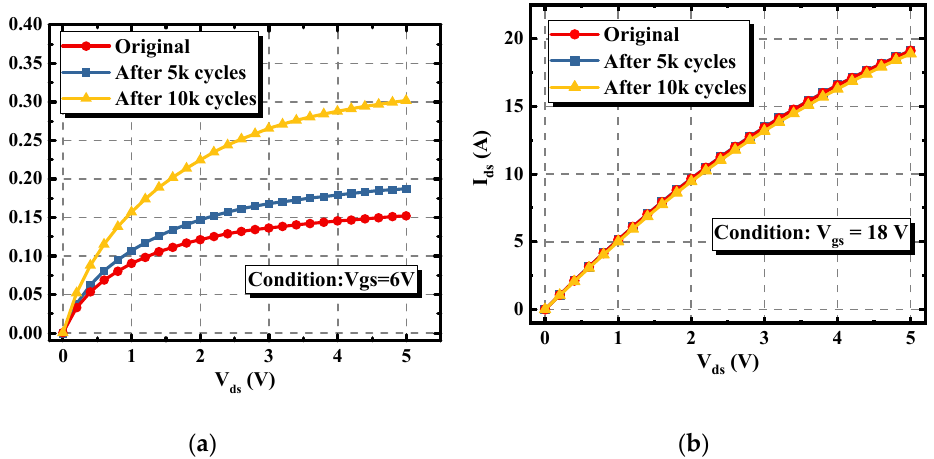
Figure 5. Variations of the I d -V d characteristic of the asymmetric trench SiC MOSFET under different avalanche stress cycles. ( a ) I d -V d curves under the V gs = 6 V bias condition. ( b ) I d -V d curves under the V gs = 18 V bias condition.